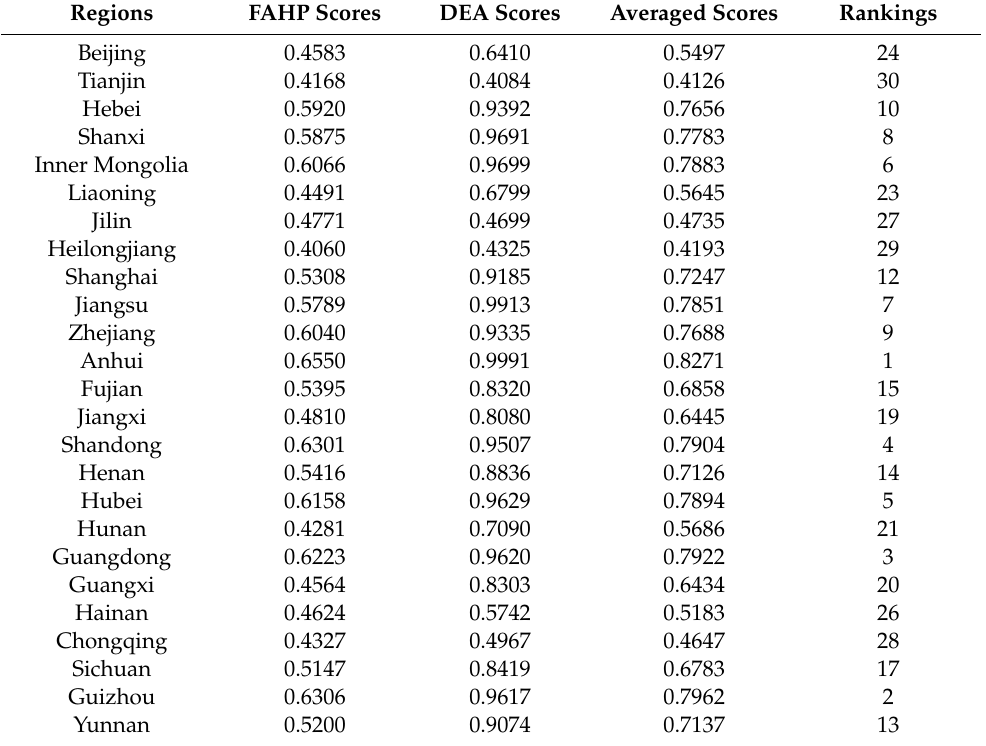
Table 6. Averaged e ffi ciency scores and rankings of the 30 Table 6. Averaged efficiency scores and rankings of the 30 regions.